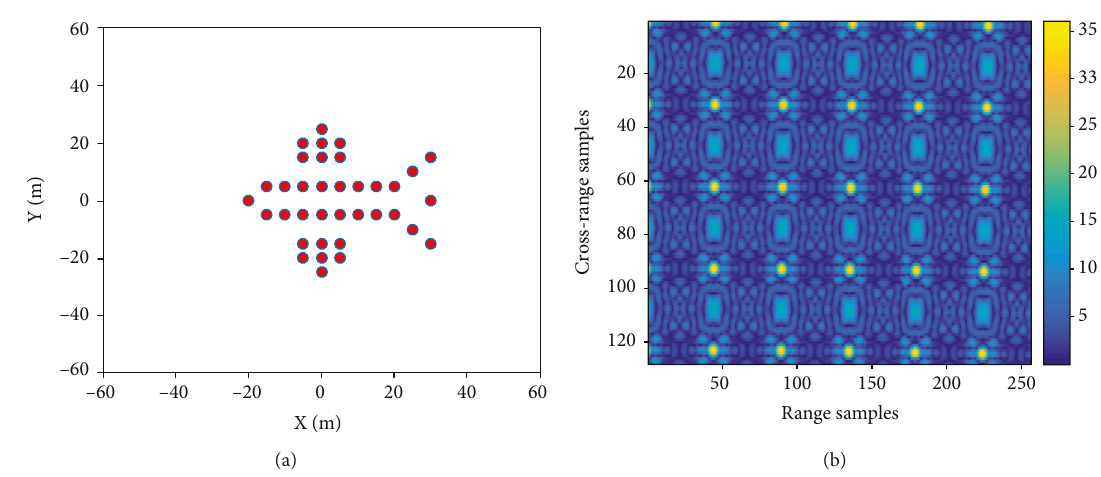
Figure 3: (a) A hypothetical target composed of perfect point scatterers [19]. (b) The amplitude of the raw data [19]. Figures reproduced from Hongyin Shi et al. (2018) (under the Creative Commons Attribution License/public